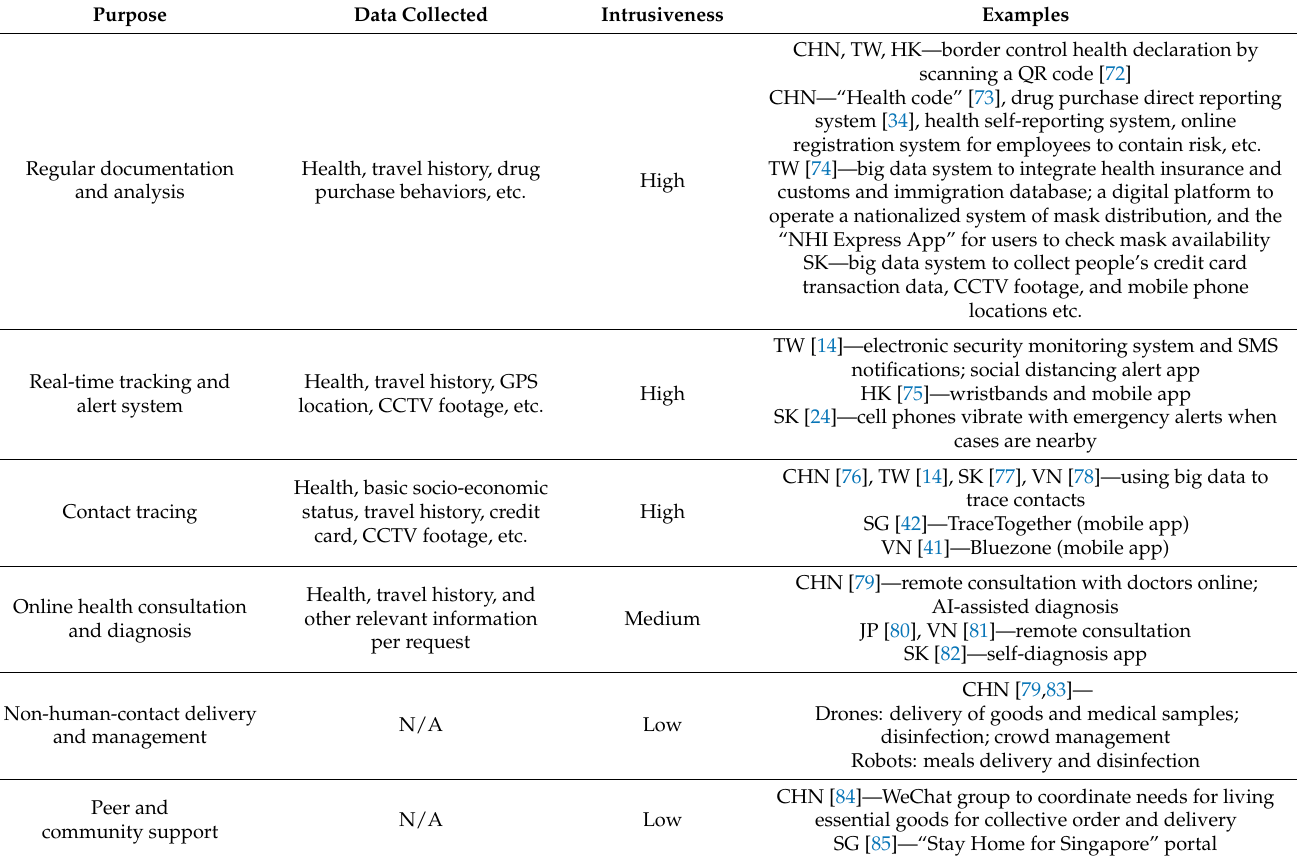
Table 3. Summary of key digital and smart tools used for controlling COVID-19 in the study sites, 1 January to 30 May 2020.